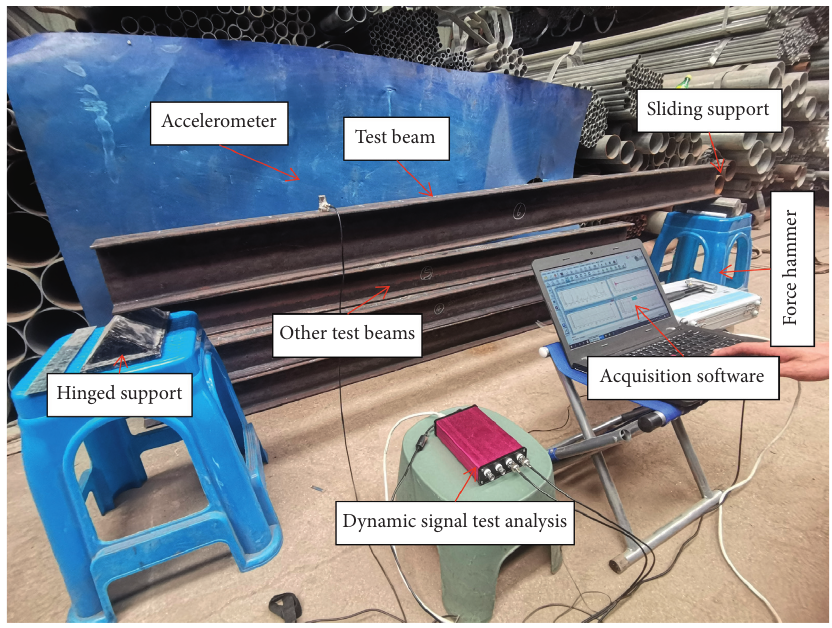
Figure 18: Experimental layout.